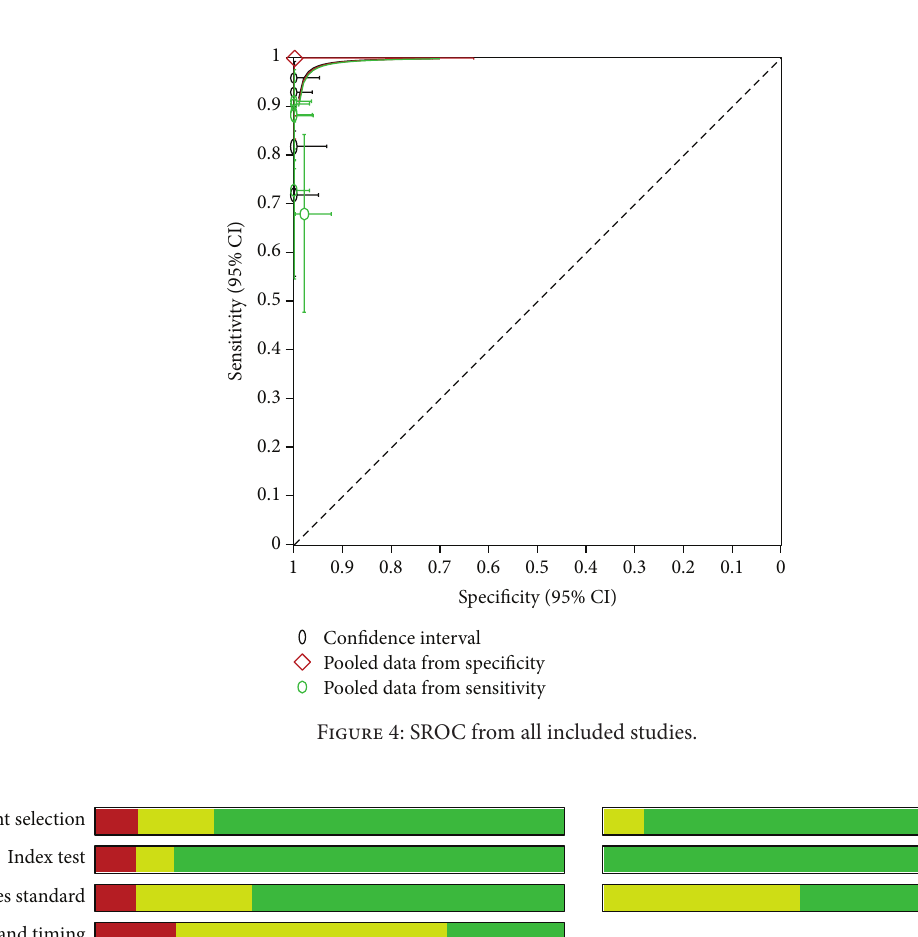
Figure 3: Comparison 1. Forest plot of diagnostic yield from all included studies.